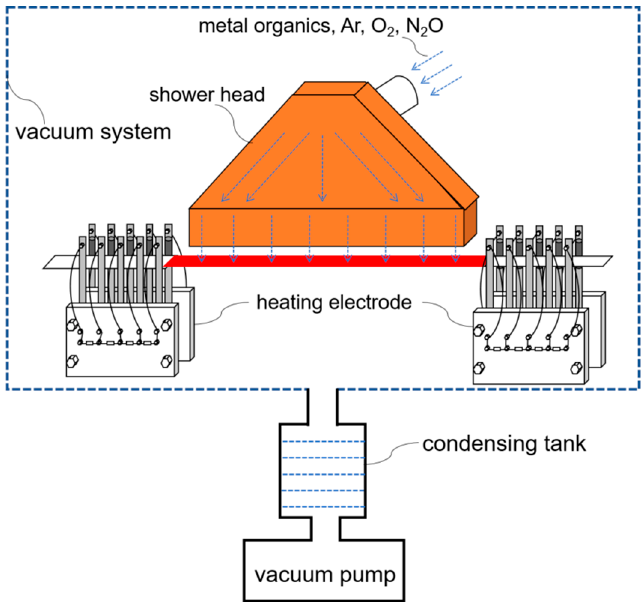
Figure 1. Schematic diagram of GdYBCO film preparation through using the self-heating technology.